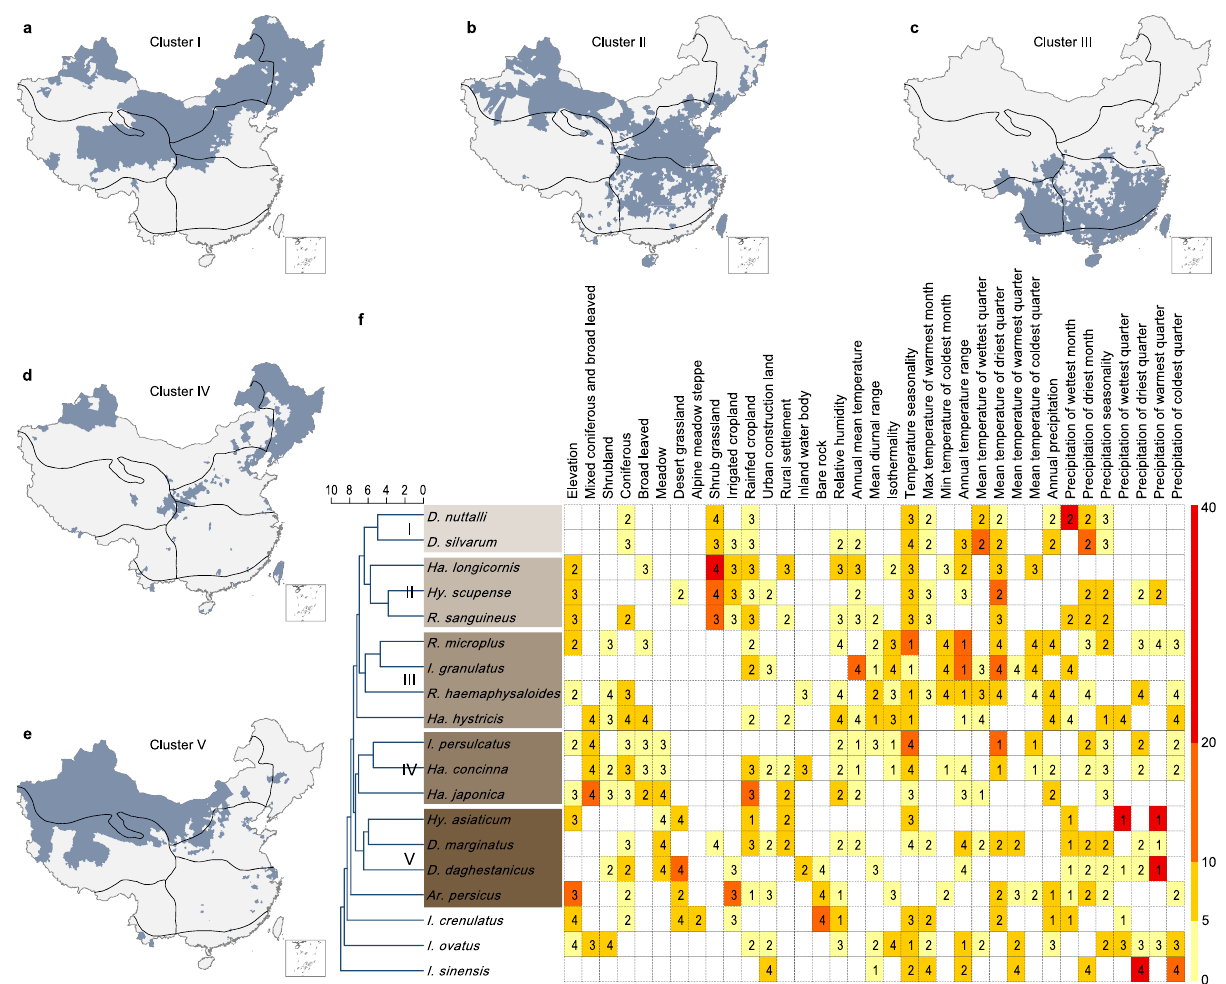
Fig. 2 Clustering of tick species based on their ecological features and spatial distributions at the county level. Panels a ‒ e indicate the spatial distribution of the fi ve clusters (clusters I ‒ V). The boundaries of the seven biogeographic zones are shown as black solid lines. The dendrogram in panel f displays the clusters I ‒ V of tick species. The features used for clustering are three quantities associated with each predictor in the BRT models. Two of the three quantities were displayed in panel f to indicate the possible level of ecological suitability: relative contributions (colors in ascending order from yellow to red) and the standardized median value of the predictor (numbers in the heatmap) among counties with tick occurrence (numbers 1 ‒ 4 indicate the position of this median in reference to the quartiles of this predictor among all counties). Source data are provided as a Source Data fi